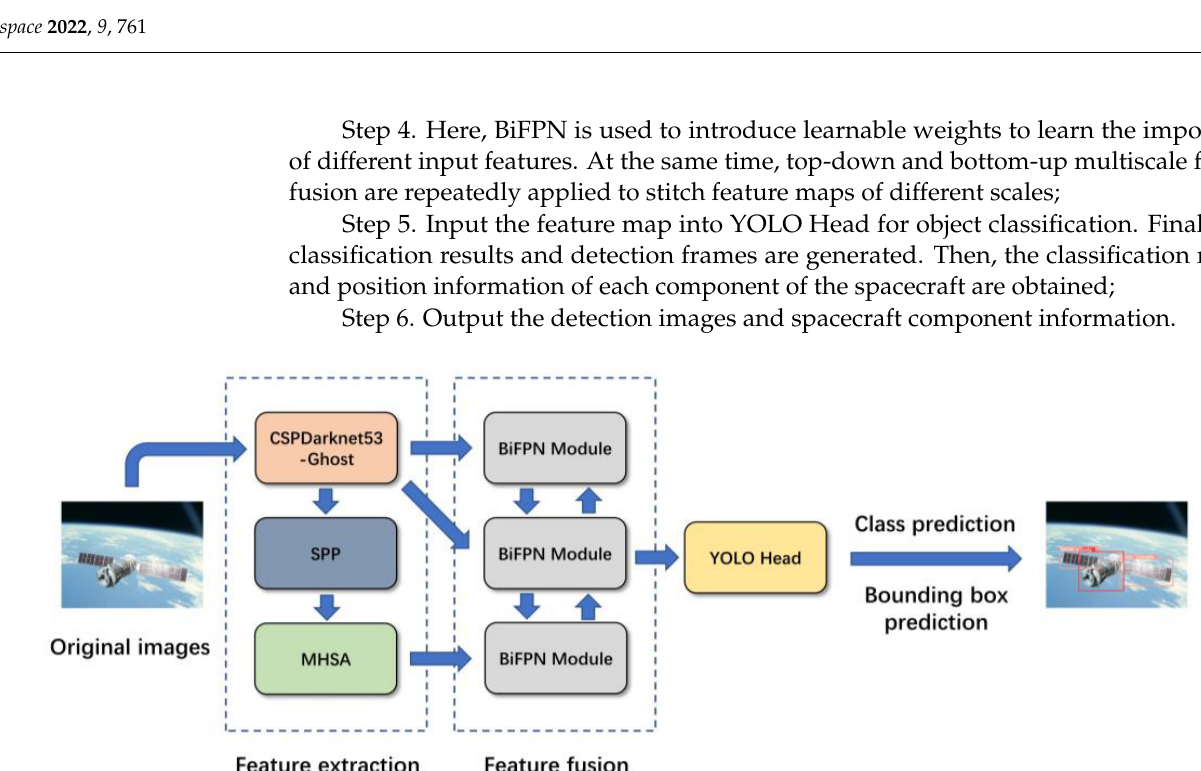
Figure 1. Overall flowchart of component detection.